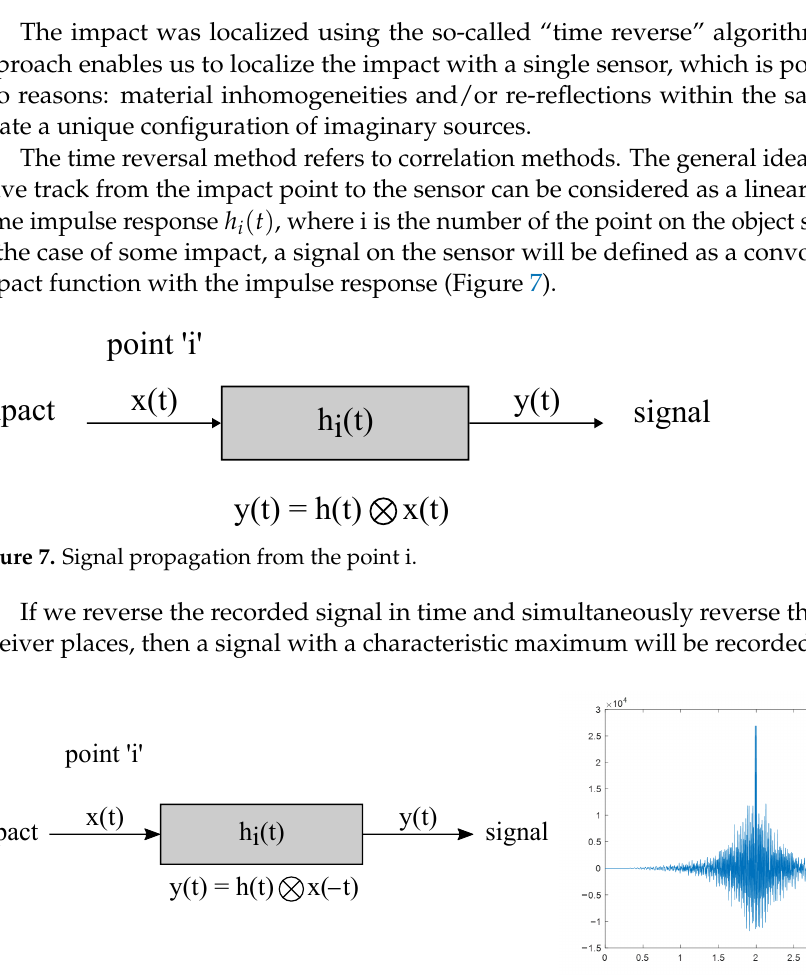
Figure 6. Tested sample.